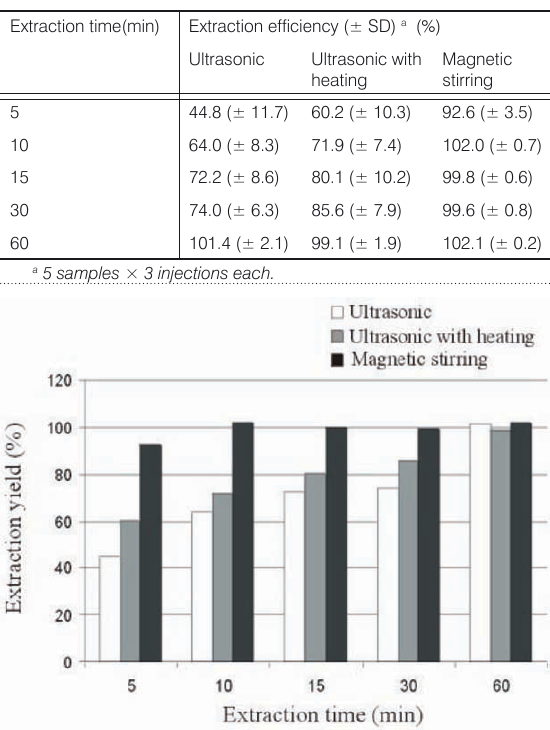
Figure 2. Graphical comparison of the extraction procedures.